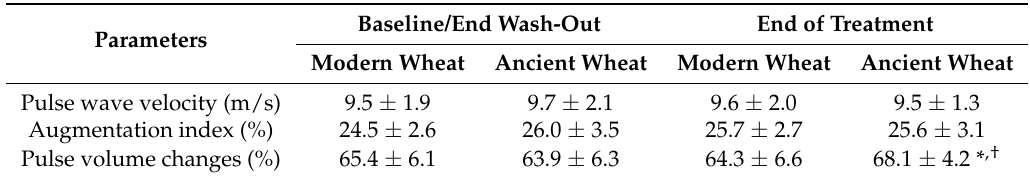
Table 7. Changes in endothelial function and arterial stiffness parameters from baseline/end washout to end of treatment, expressed as mean ± standard